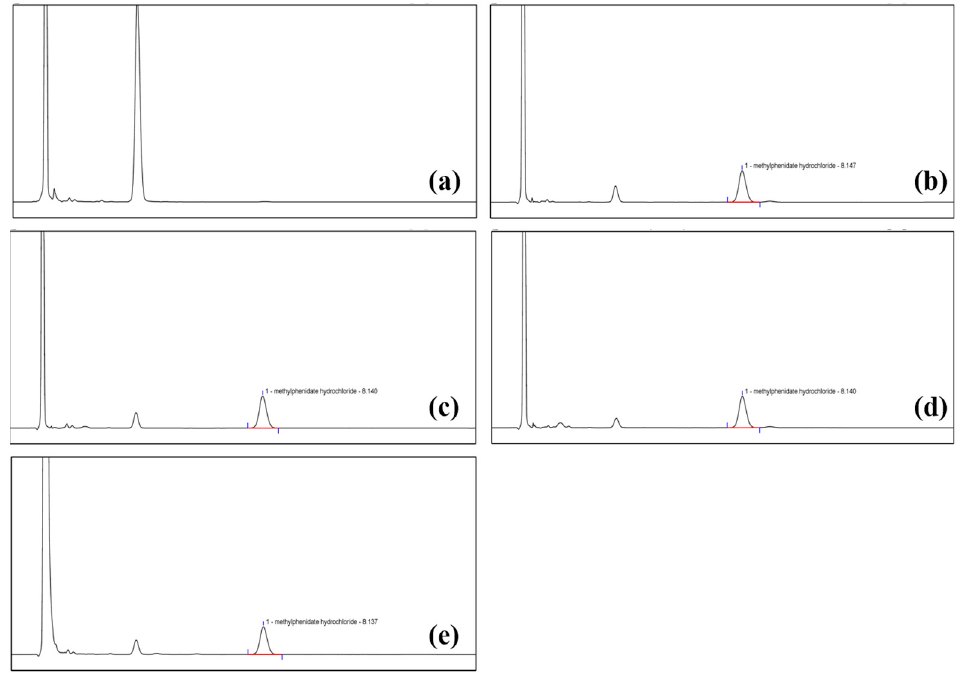
Figure 6. The results of specificity for ( a ) blank excipients, ( b ) test solution, ( c ) degradation products of acid, ( d ) degradation products of the base, and ( e ) degradation products of oxygen. Table 6. Results of analytical method validation.